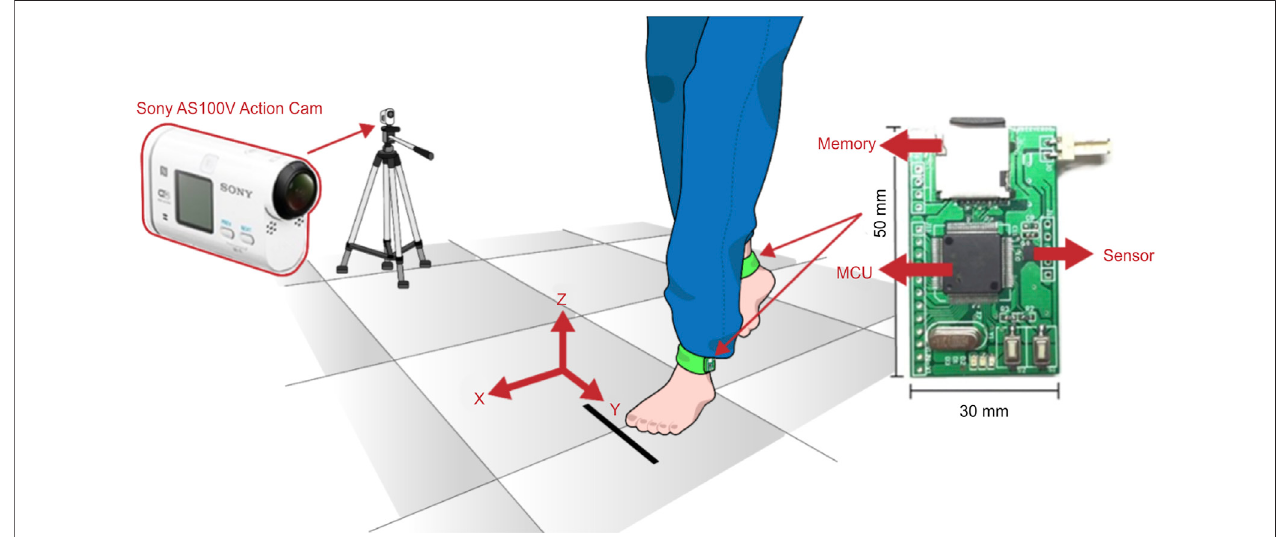
FIGURE 2 | Wearable sensors, measuring coordinates, and gait image records for the experiment con fi guration. MCU: microcontroller unit.